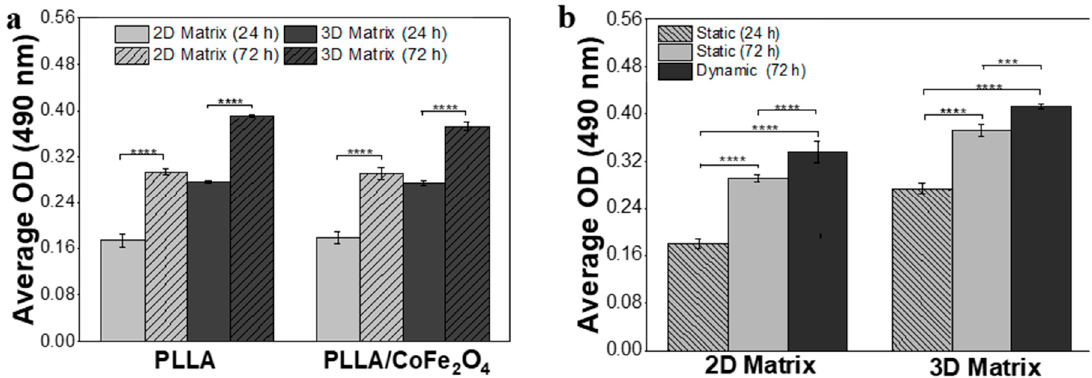
Figure 6. MC3T3-E1 proliferation in the hydrogel matrix containing ( a ) neat and magnetic microspheres, under the static condition and in both matrices; and ( b ) magnetic microspheres under dynamic conditions and in both matrices. *** p < 0.001; **** p < 0.0001.